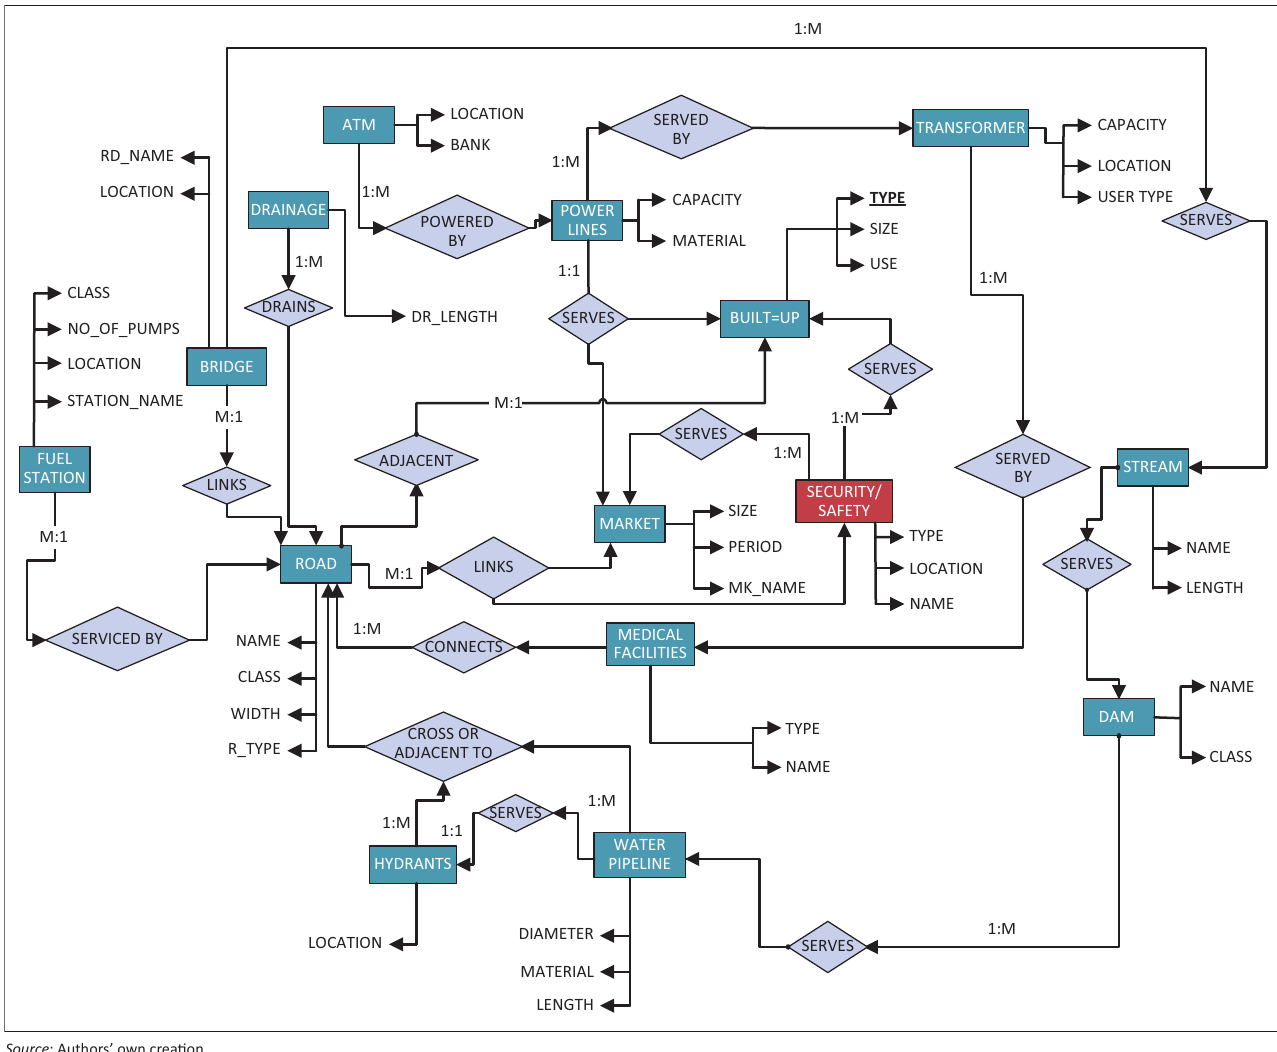
FIGURE 4: ER diagram adopted for the